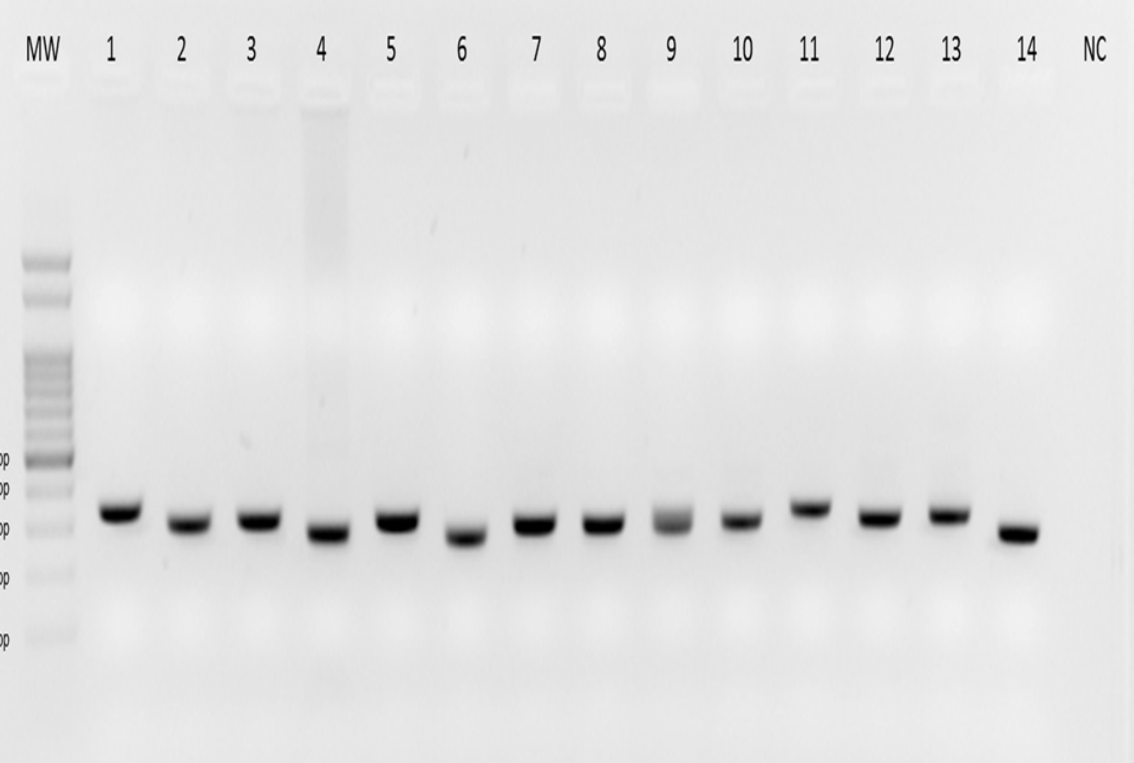
Fig 2. Detection of Leishmania in sand flies collected from trails in the Xakriabá Indigenous Reserve, Brazil, during the study period. Sand flies were pooled with up to ten specimens of the same locality, species and date, and ITS1 PCR was performed with total DNA extracted from these pools. The figure represents an ethidium bromide-stained 2% agarose gel in which the amplicons were submitted to electrophoresis. Lanes: MW, molecular weight marker — 100 bp; lanes 1 – 4, positive controls of Le . amazonensis (IFLA/BR/67/PH8), Le . braziliensis (MHOM/BR/75/M2903), Le . infantum (MHOM/BR/74/ PP75), Le . guyanensis (MHOM/BR/75/M4147) respectively; 5 – 14, phlebotomine positive pools; NC, negative